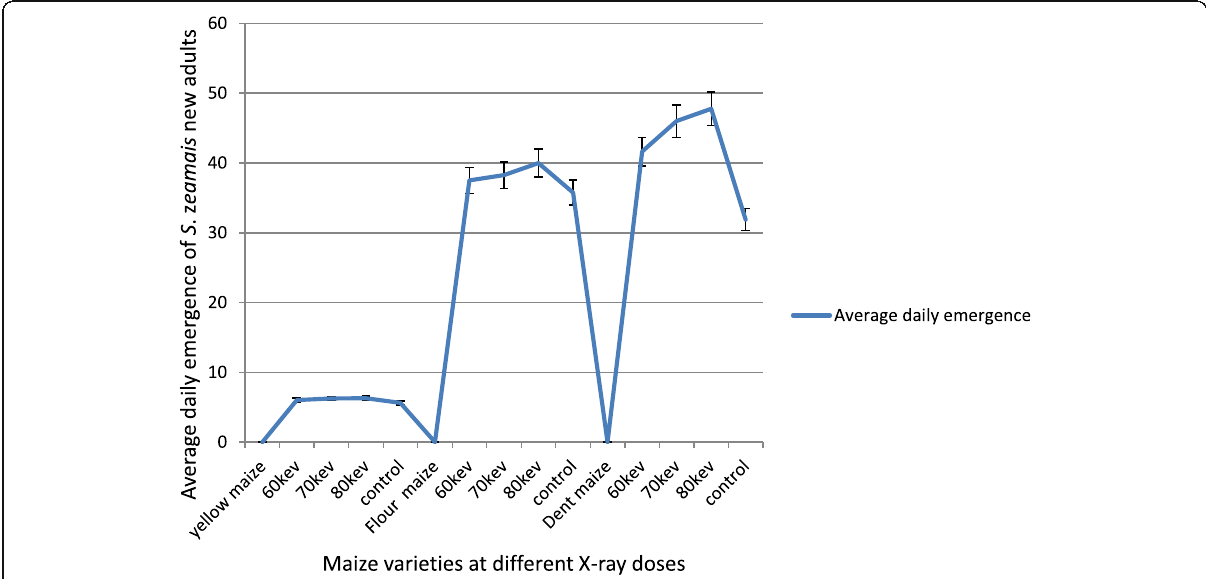
Fig. 3 Effect of X-ray exposure dose (KeV) on the daily emergence of new Sitophilus zeamais Motschulsky adults from three varieties of